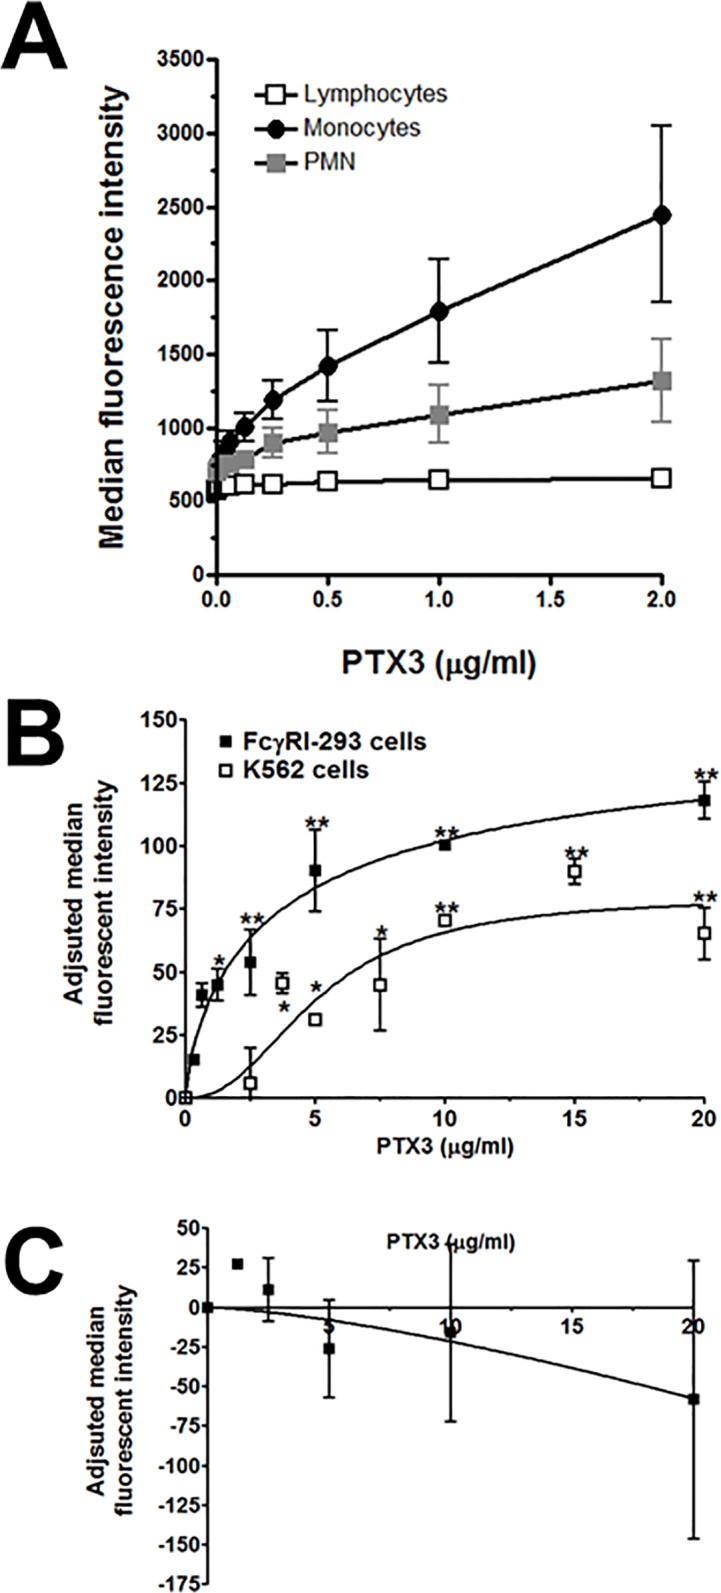
Alexa Fluor 647–labeled PTX3 binds to FcγRI and FcγRIIA.A) PTX3-647 was incubated with isolated leukocytes and then subjected to flow cytometry. Neutrophils, monocytes, and lymphocytes were identified based on forward scatter and side scatter. Curves are fits of the resulting data to models of one or two-site binding with variable Hill coefficient. B) HEK293 cells expressing FcγRI, or K562 cells, which express FcγRIIA and C) HEK293 cells expressing FcγRIIIB were incubated with PTX3-647. The cells were then washed, and the binding of the labeled PTX3 to the cells was measured by flow cytometry. Autofluorescence values were subtracted from the total binding values. Median fluorescence intensity values were normalized to the intensity value of 1 μg/ml concentration. Values are normalized mean ± SEM, n = 3–6. Curves are fits to models of one-site binding with variable Hill coefficient. The absence of error bars indicates that the error was smaller than the plot symbol. *p <0.05, **p <0.01 (1-way ANOVA, Dunnett's test), compared to no PTX3-647 binding.